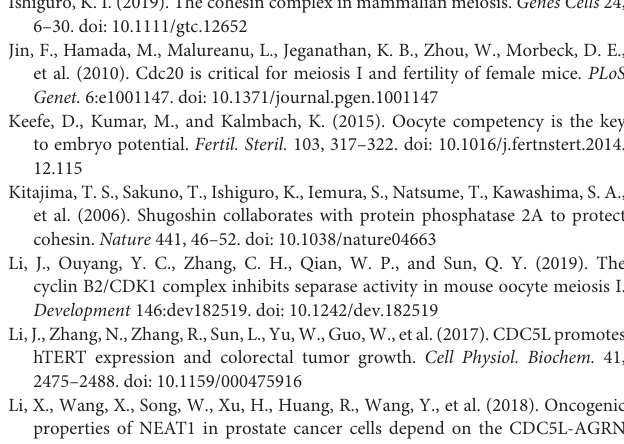
Supplementary Figure 1 | Immunofluorescence staining of spindle assembly and chromosome alignment after culture for 8 h following release from IBMX in both control and Cdc5L siRNA injected oocytes. The oocytes were analyzed for each group as follows: Ctrl, n = 16; Cdc5L siRNA, n = 17. Supplementary Figure 2 | Representative fluorescence intensity for CCNB1 and Bub3. (A) The fluorescence intensity of CCNB1 was analyzed in both control and Cdc5L siRNA oocytes. Data are shown as means ± SEM. “*” represents P < 0.05; “**” represents P < 0.01. At least three replications were conducted. (B) The fluorescence intensity of Bub3 was analyzed in both control and Cdc5L siRNA oocytes. Data are shown as means ± SEM. “*” represents P < 0.05; “**” represents P < 0.01. At least three replications were conducted. Supplementary Figure 3 | Overexpression of Cdc5L mRNA accelerated metaphase-to-anaphase during meiosis I. (A) Percentages of PBE were quantified in the control and Cdc5L mRNA oocytes. Data are shown as means ± SEM. “*” represents P < 0.05; “**” represents P < 0.01. At least three replications were conducted. The oocytes were analyzed for each group as follow: Ctrl, n = 128; Cdc5L mRNA, n = 117. (B) Expression of SMC3 and Securin protein as revealed by Western blotting analysis. The oocytes were collected 9.5 h after release from IBMX (150 oocytes per sample). At least three replications were conducted and 450 oocytes were used for each group. Data are shown as means ± SEM. “*” represents P < 0.05; “**” represents P < 0.01. Supplementary Movie 1 | Representative time-lapse fluorescence measurement of securin in control and Cdc5L siRNA group. (A) The securin-mCherry mRNA was expressed in control oocytes. Scale bar, 50 µ m. (B) The securin-mCherry mRNA was expressed in Cdc5L siRNA oocytes. Scale bar, 50 µ